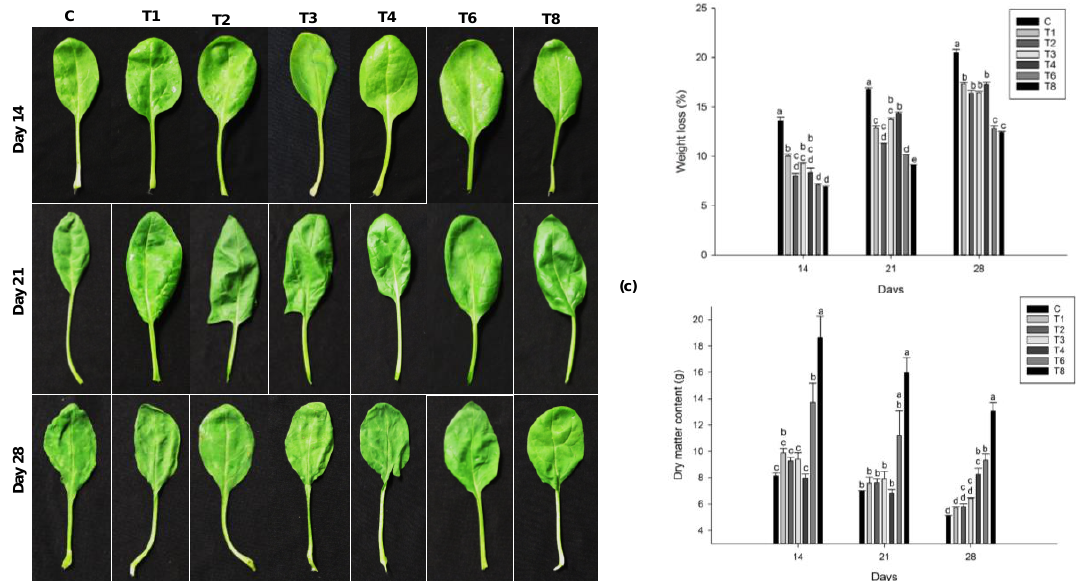
Figure 3. Effect of pretreatment of ANE and HA on fresh weight loss and dry matter content during postharvest storage of spinach. ( a ) This figure represents leaves of spinach treated with different concentrations of ANE and HA, alone and their combinations, over 14, 21, and 28 days of storage at 0–4 °C in the dark with RH ≥ 95%. The postharvest ( b ) fresh weight loss and ( c ) dry matter content (DMC) of spinach leaves after 14, 21, and 28 days of post-harvest storage at 0–4 °C in the dark with RH ≥ 95%. Different combinations of ANE and HA used for preharvest treatment were as follows: C (control), T1 (0.1% ANE), T2 (0.25% ANE), T3 (0.2% HA), T4 (0.4% HA), T6 (0.1% ANE + 0.4% HA), and T8 (0.25% ANE + 0.2% HA). Each experiment was performed in triplicate, and each experimental unit had six plants. The average of the eighteen values were presented as mean ± SE and means represented by same letters were not significantly different at p ≤ 0.05.